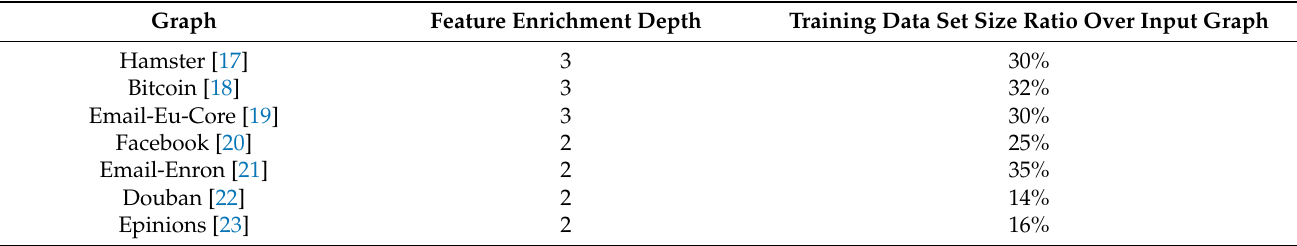
Table 2. Distributed logistic regression [15] community prediction methodology execution parameters per distinct social graph.